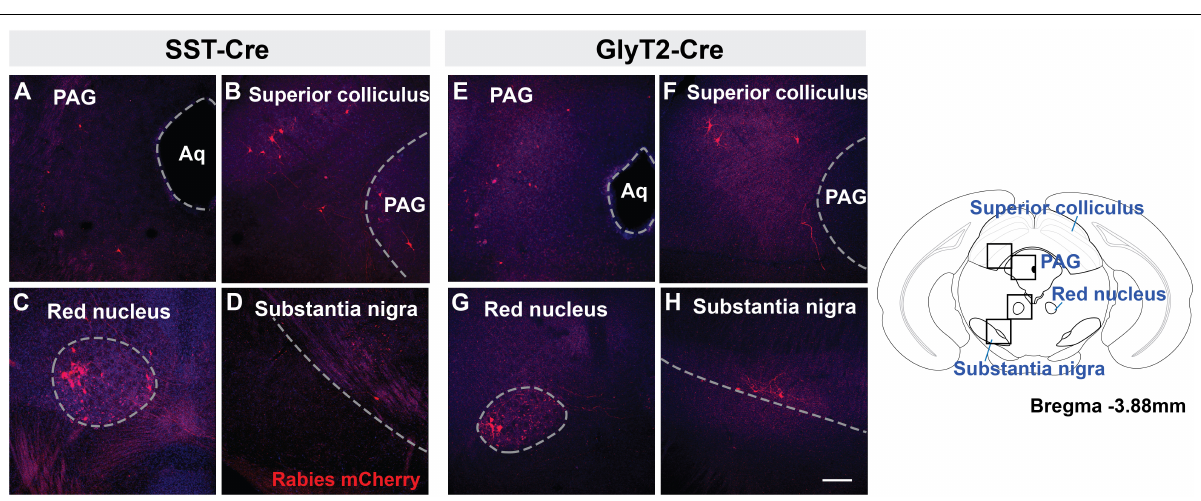
injection. Labeled neurons were observed in the in the dorsolateral PAG ( Figures 3A,E ) as well as the superior, but not in the inferior, colliculus ( Figures 3B,F ). In some instances ( n = 3 of 5 SST-Cre and n = 3 of 4 GlyT2- Cre), neurons in the lateral portion of the magnocellular red